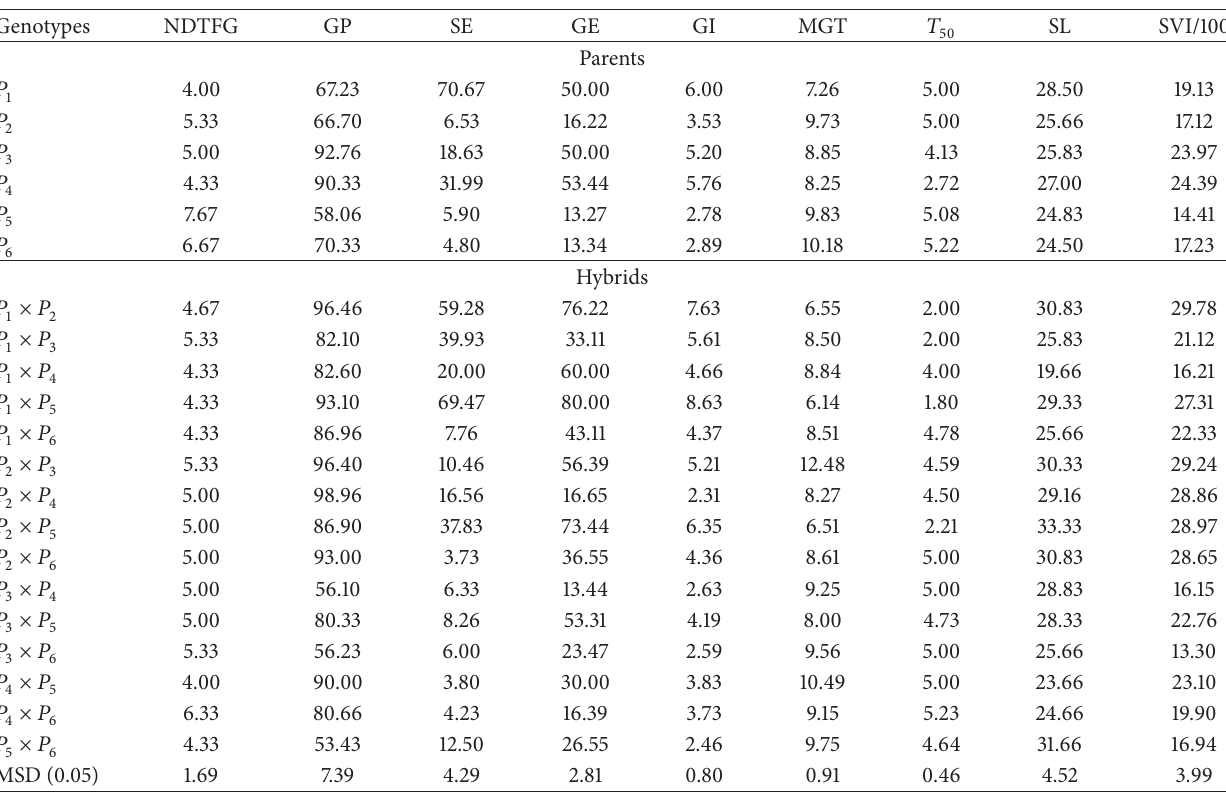
Table 2: Performance of parents and their hybrids for nine germination parameters in Jatropha curcas